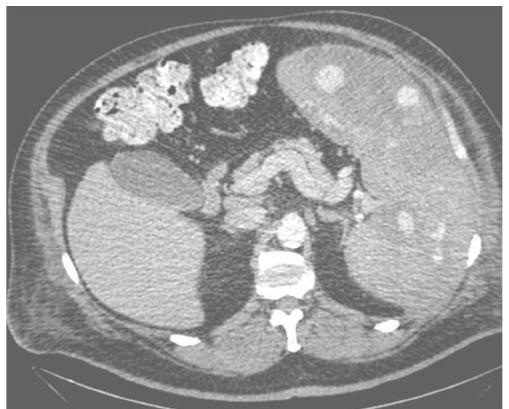
Figure 2: Lesions showing intense enhancement on post contrast CT images.